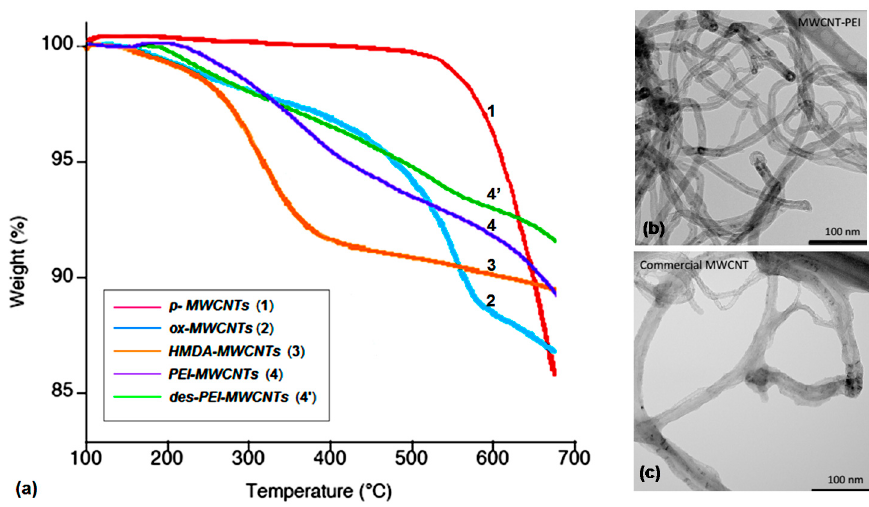
Figure 3. ( a ) TGA profiles of MWCNTs 1-4’ ; TEM images of ( b ) PEI-MWCNTs ( 4 ) and ( c ) p-MWCNTs ( 1 ).